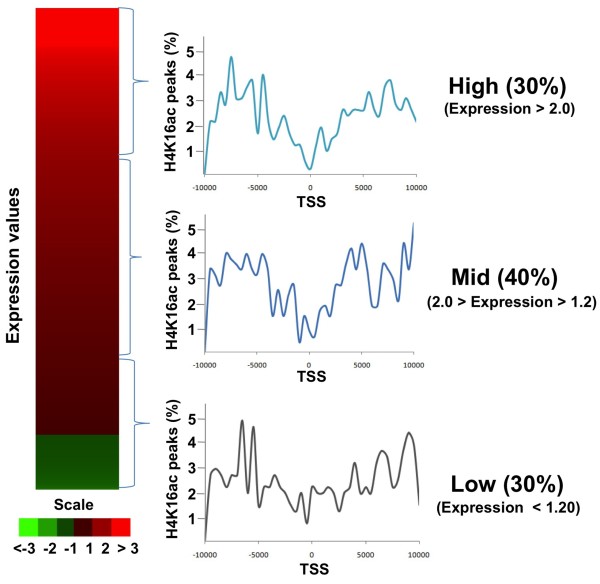
Localization of H4K14ac peaks in genes. Untreated HEK293 gene expression profiling data were used to determine the expression levels of entire genes and divided into three categories: top 30% high expression genes, bottom 30% low expression genes, middle 40% genes between. In each category, H4K16ac peak distribution with respect to TSS was determined and displayed.